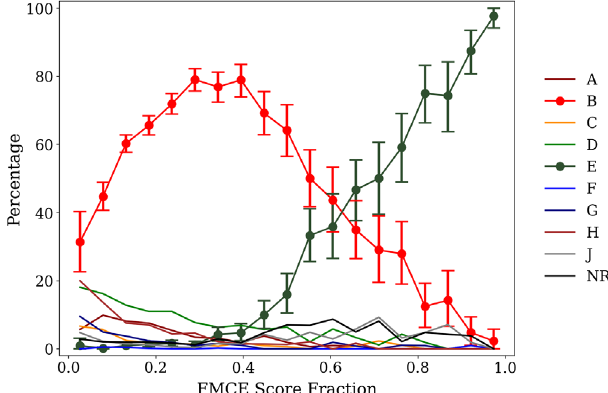
FIG. 1. Item response curves for 6584 American students (the RSW dataset) for item 17 on the FMCE. NR ¼ no response. The error bars on E (the correct answer) and B (the most commonly chosen incorrect answer) are the 95% confidence intervals of 10 000 bootstrapped sample datasets based on the RSW data described in Sec. III C. For visual clarity, specific plot markers and error bars are omitted for less frequently chosen